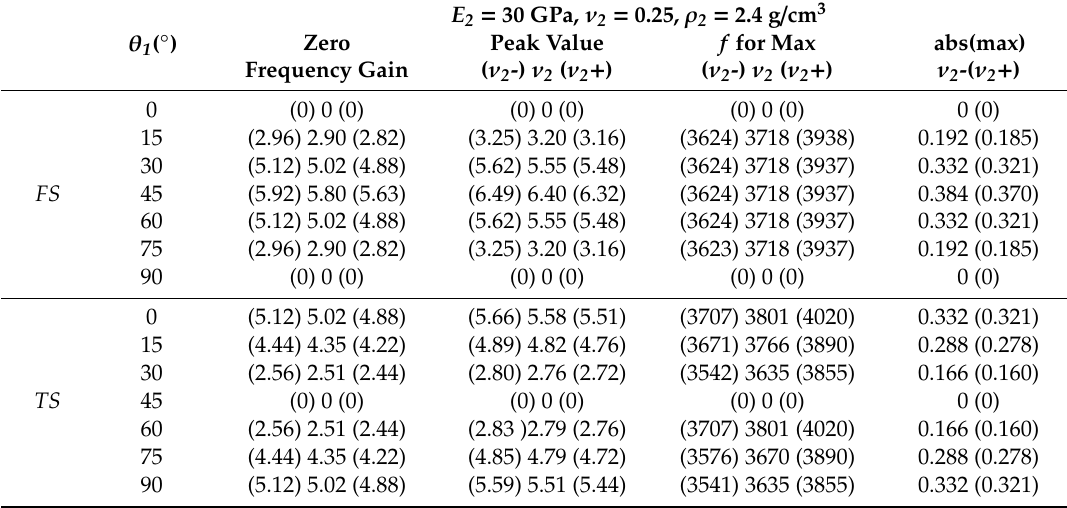
Table 7. Influence of the Poisson’s ratio of the expansive grout on theoretical amplitude spectrum of gauge combinations FS and TS for the incident S wave.